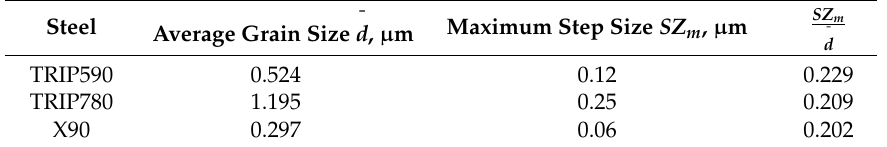
Table 6. The relationship between the maximum step size and the average grain size of retained austenite.